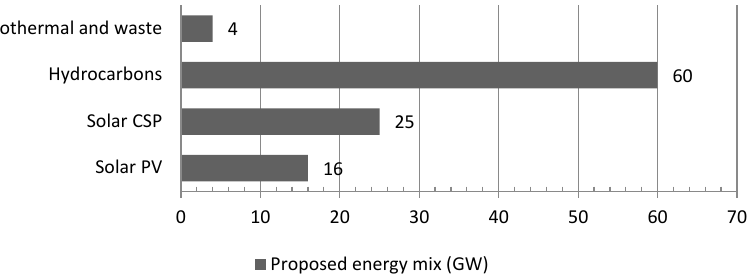
Figure 3. Proposed energy mix of Saudi Arabia until 2032.